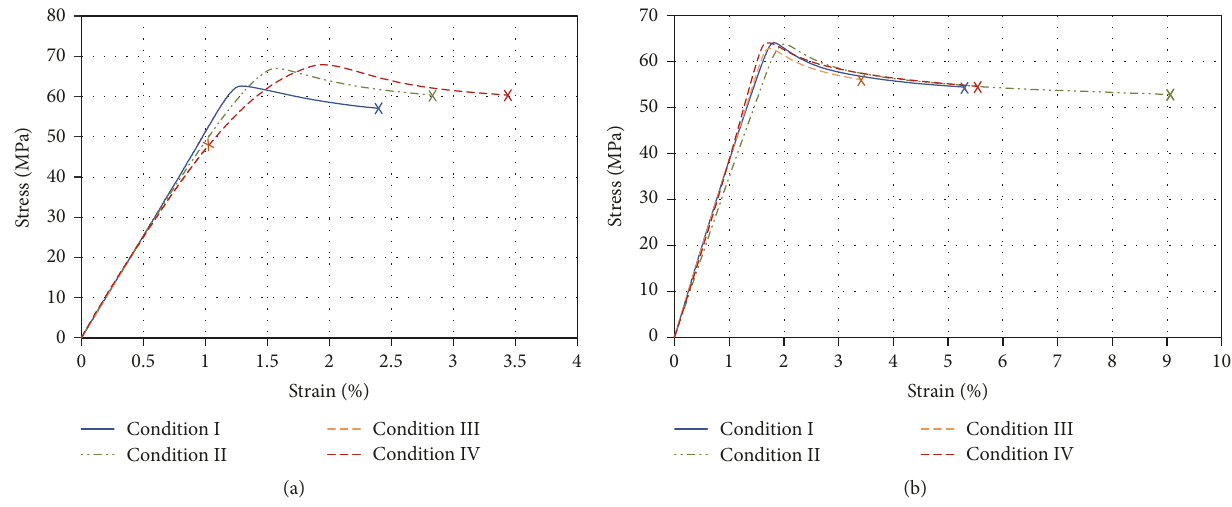
Figure 2: Stress-strain curves (means) of notched (a) and unnotched (b) specimens of injection molded PLGA.